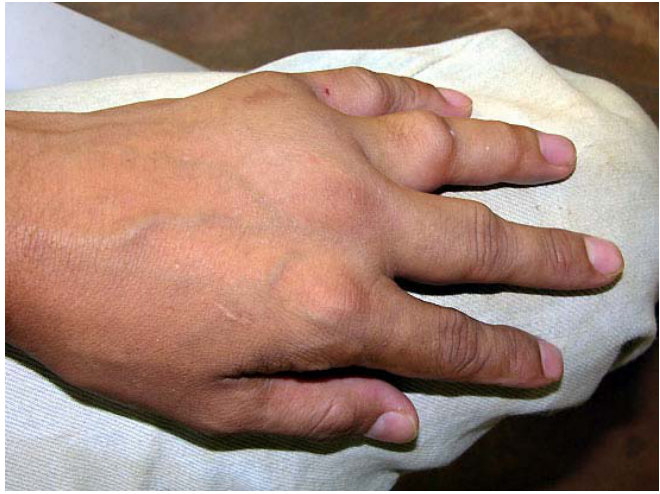
Figure 3: Maximum swelling of the left hand and fingers photographed 130 min after the bite (Case